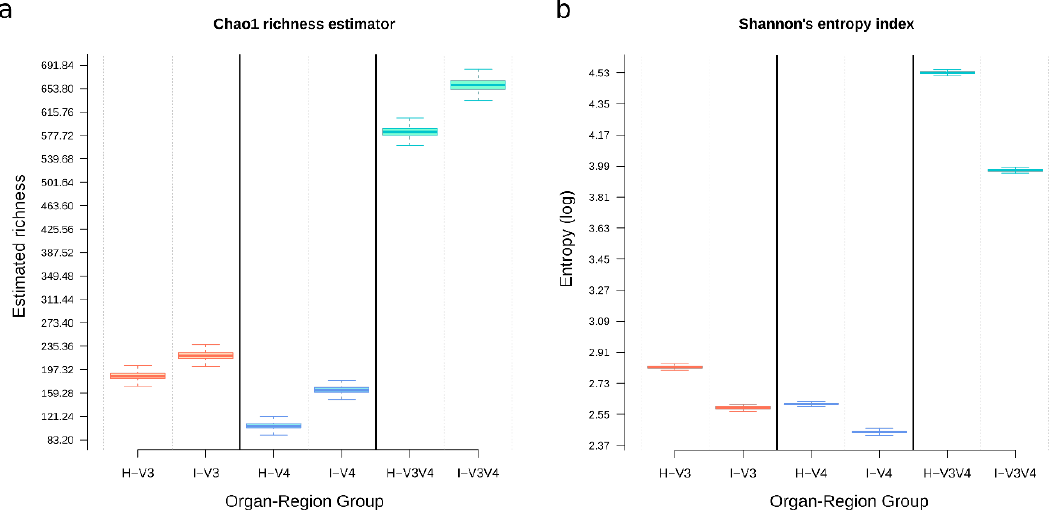
Figure 8. OTU richness (Chao1) and diversity (Shannon) by organ-region set. The distribution of means from index values in 10,000 Montecarlo repetitions drawn from the original table. Outliers are not shown. ( a ) Chao 1 estimated richness and ( b ) Shannon–Weaver’s entropy.